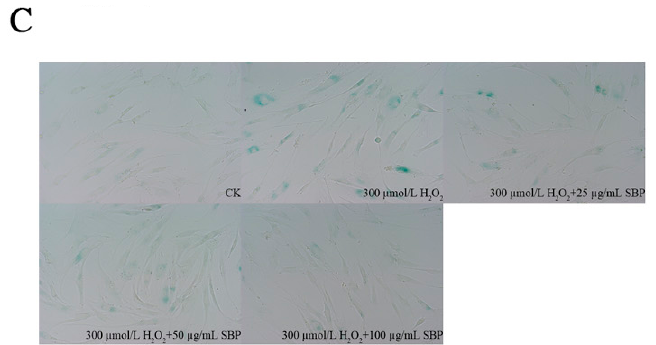
Figure 2. Cell morphology and cell viability of SBP in H 2 O 2 -induced senescent cells. ( A ) Effects of different SBP concentrations on cell morphology in H 2 O 2 -induced senescence HSFs observed by an ordinary light microscope. ( B ) CCK-8 method to detect the effects of different SBP concentrations on cell viability in H 2 O 2 -induced senescent HSFs. ( C ) β -galactosidase staining method to verify the anti- aging effect of different SBP concentrations on H 2 O 2 -induced senescent HSFs. In the figure “+” means added, “ − ” means not added. The results are the mean ± SD of three independent experiments. *** p < 0.001 indicate significant differences compared with the various experimental groups.